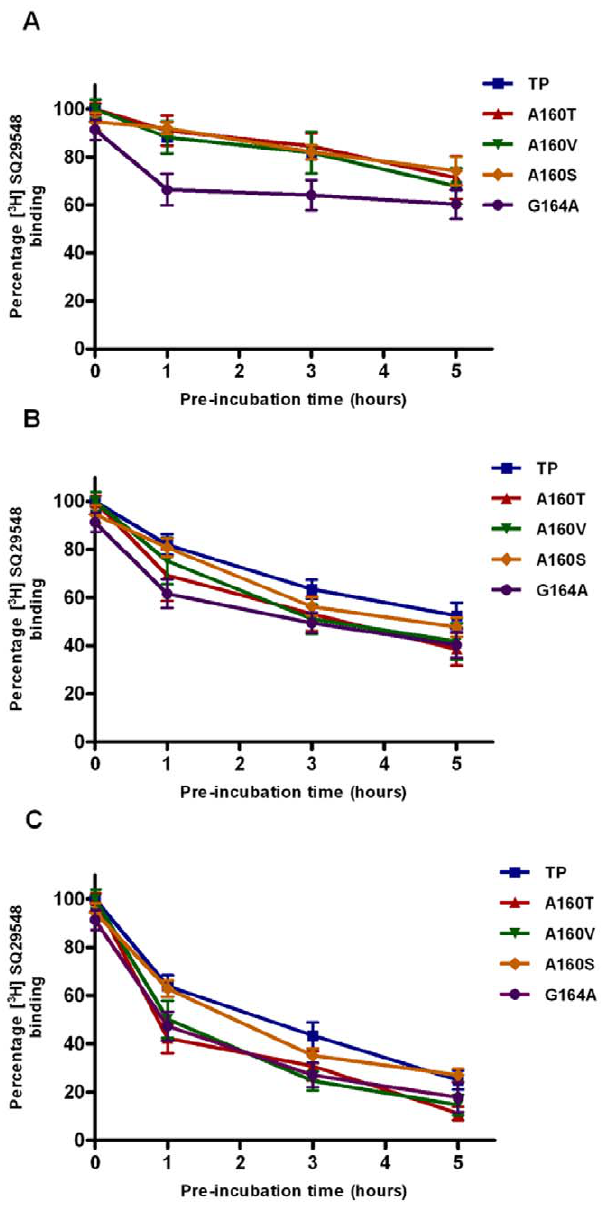
Figure 6. Thermal sensitivity of wild type TP and select mutants. It was measured in terms of the ability of the TP and mutants at positions 4.53 and 4.57 to retain antagonist binding after incubation at 25 u C (panel A), 37 u C (panel B) and 42 u C (panel C) as a function of time. The receptor activity decreased in the order, TP . A160S . A160V . A160T . G164A, with G164A being the least stable. The results are mean 6 SE and are from minimum of three independent experiments done in